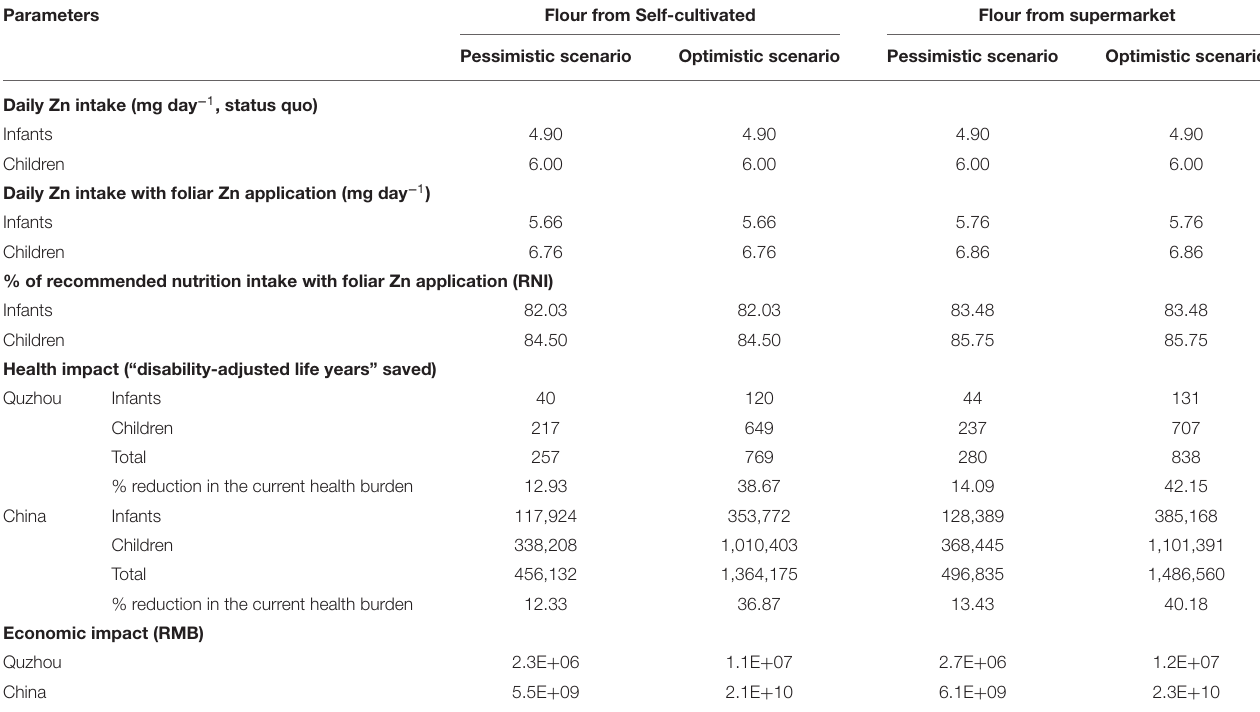
TABLE 2 | Health and economic impacts of Zn-biofortified wheat flour on the rural households in Quzhou County and China. Parameters Flour from Self-cultivated Flour from supermarket Pessimistic scenario Optimistic scenario Pessimistic scenario Optimistic